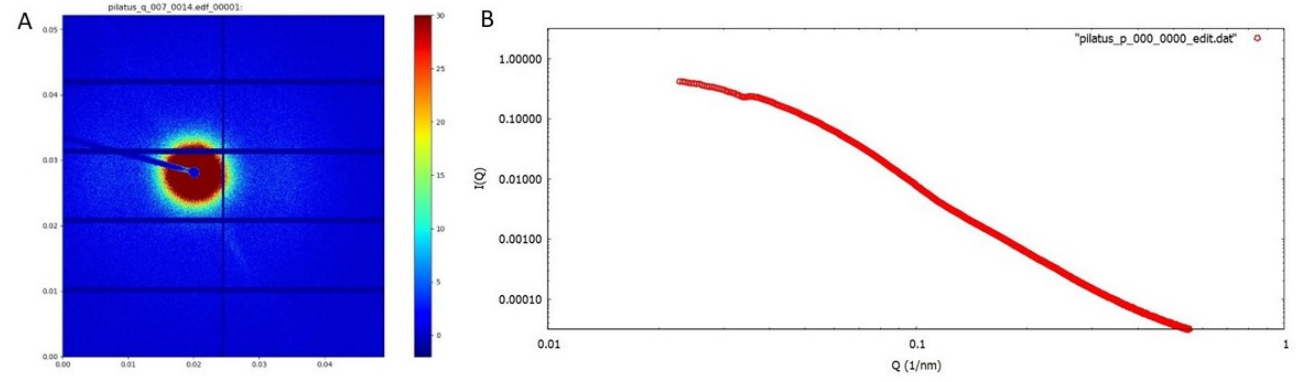
Figure 4. The injection moulding system developed in this work mounted on the NCD-SWEET Beamline. The incident beam enters from the left and the small-angle X-ray scattering detector is mounted 6.7 m to the right and is connected via a vacuum tube which has a conical front piece, which is located very close to the exit side of the mould. The dark blue box which can be observed just above the vacuum tube is the wide-angle X-ray scattering detector which was not used in these experiments.